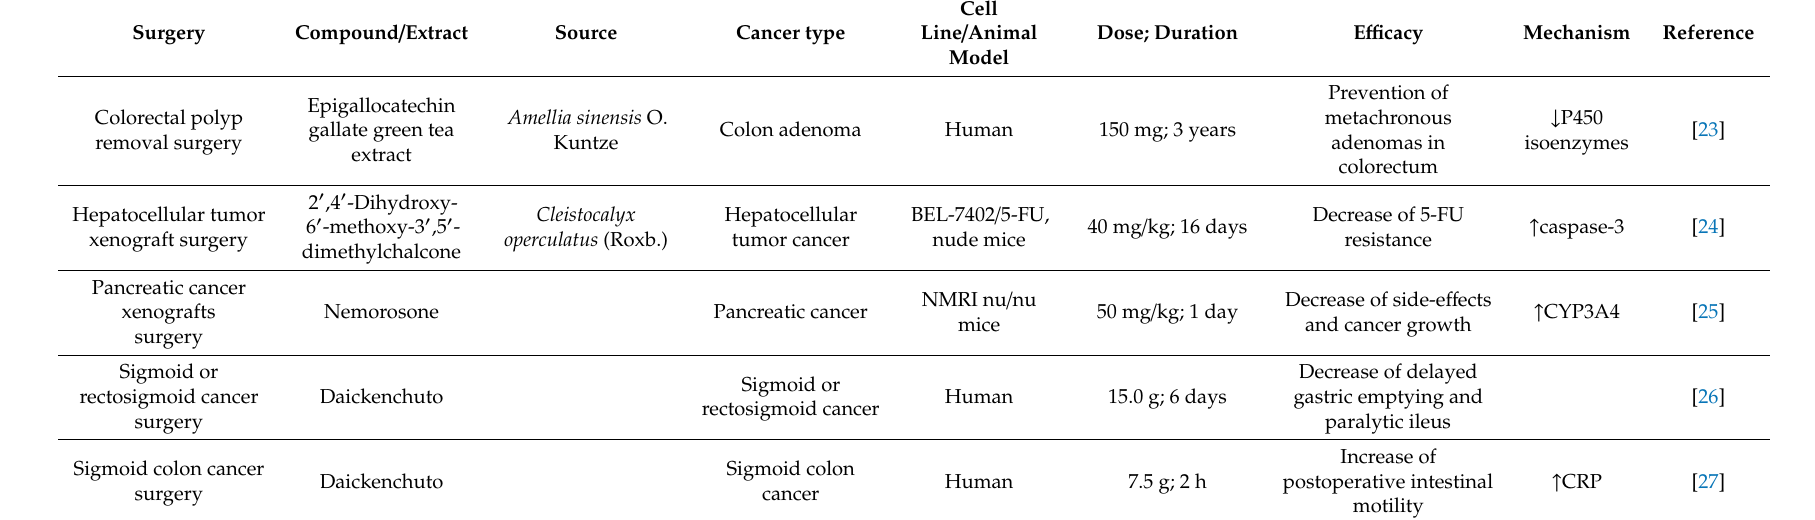
Table 1. Plant-derived drugs and sequela of